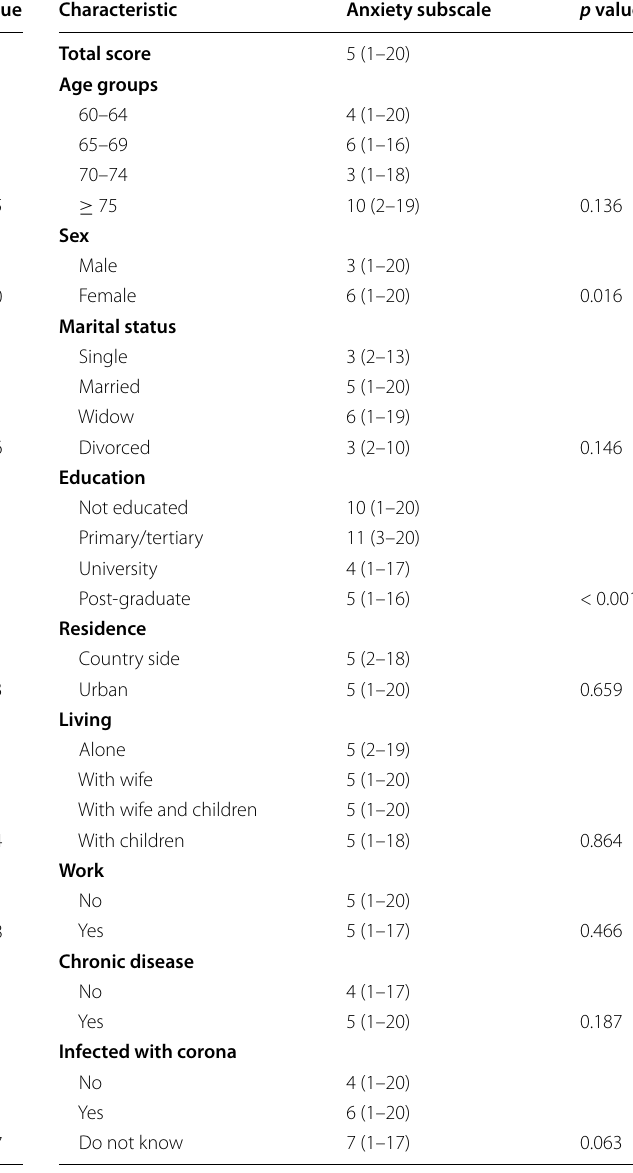
Table 2 Relation between fear of COVID-19 scale and socio- Table 3 Relation between anxiety subscale of HADS and socio- demographic